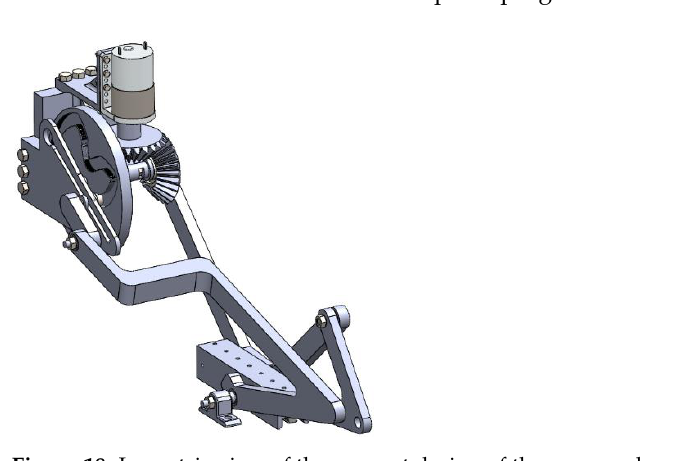
Figure 18. Isometric view of the concept design of the proposed mechanism.